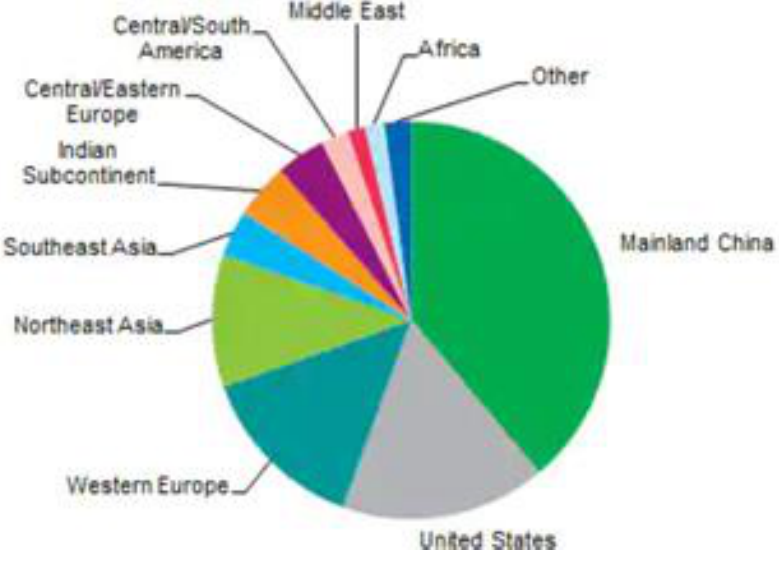
Figure 8. Global consumption of activated carbon in 2020 [45].